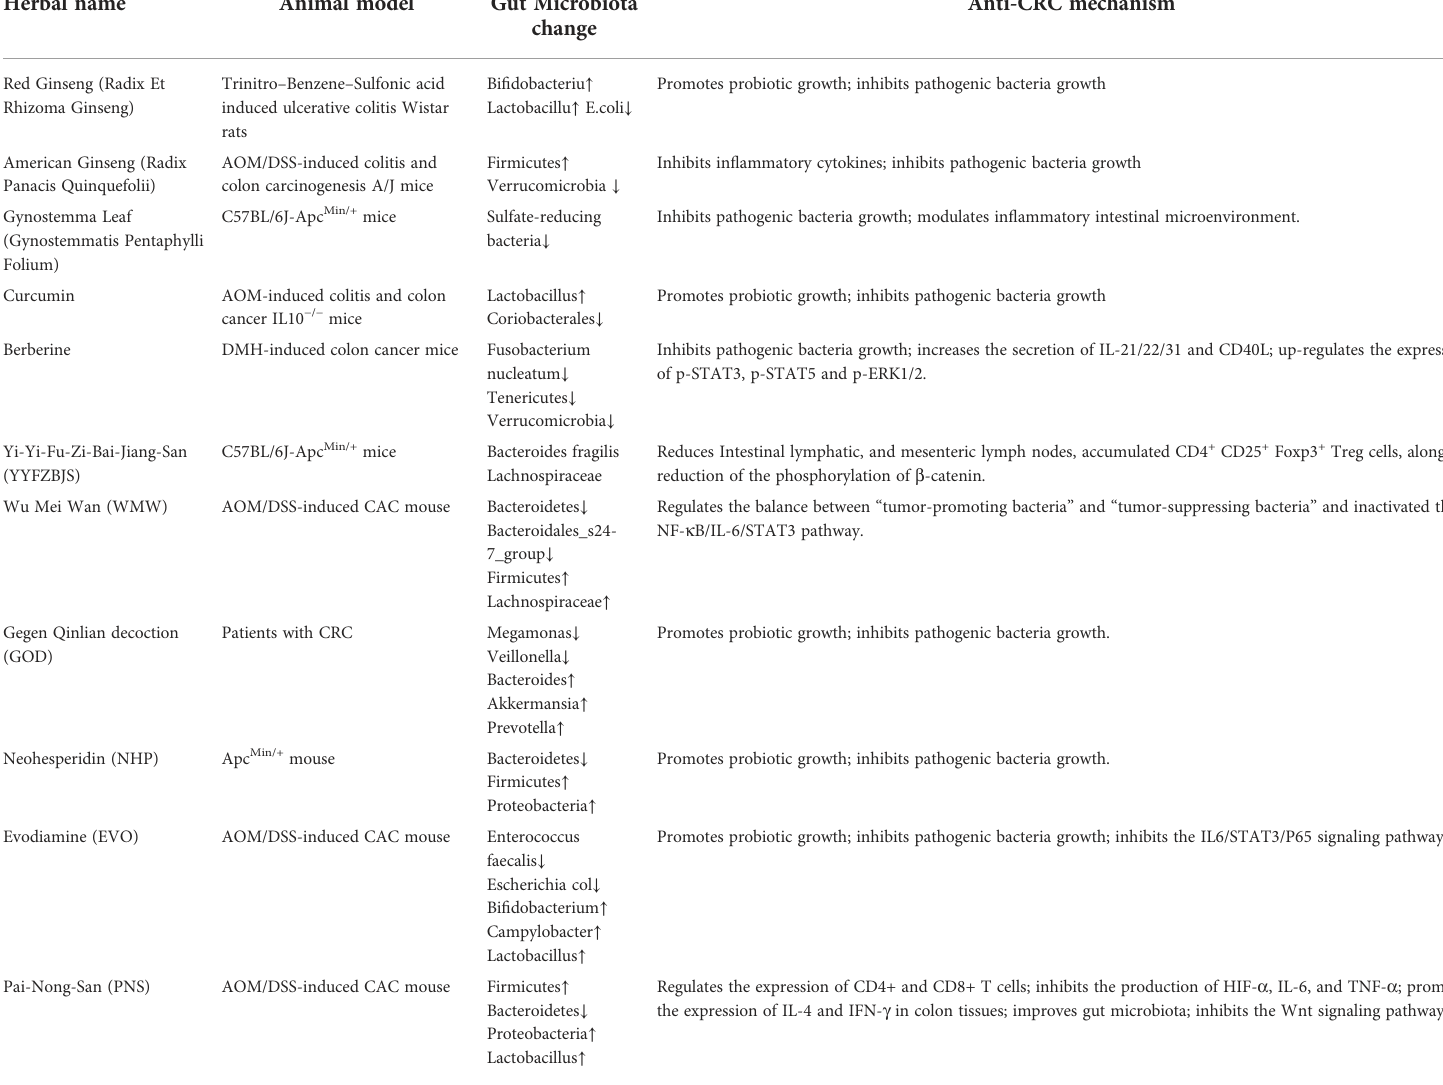
Table 1 Regulation of herbal medicine on gut microbiota changes in CRC-related animal models. Herbal